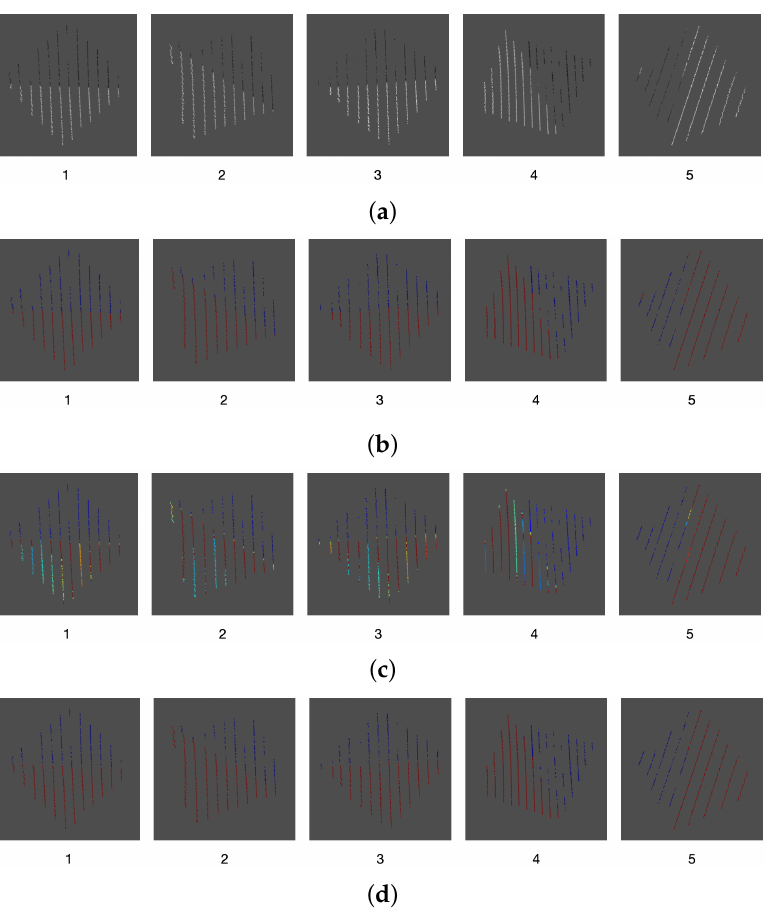
Figure 16. Key points estimation in a 3D point cloud. (a) Point cloud of the calibration board. (b) Extraction of points belonging to the edges of the calibration board. (c) Edge lines intersection and estimated key points. (d) Projection of the key points into the 3D space.